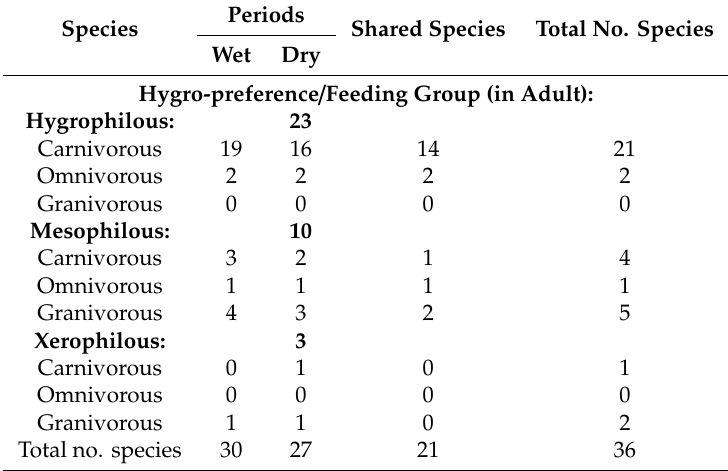
Table 2. Characteristics of the species composition of the ground beetle assemblage in climatically di ff erent conditions by their trophic requirement and humidity preference.